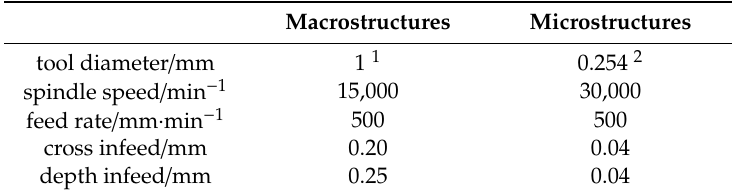
Table 1. Overview of the employed milling tools and